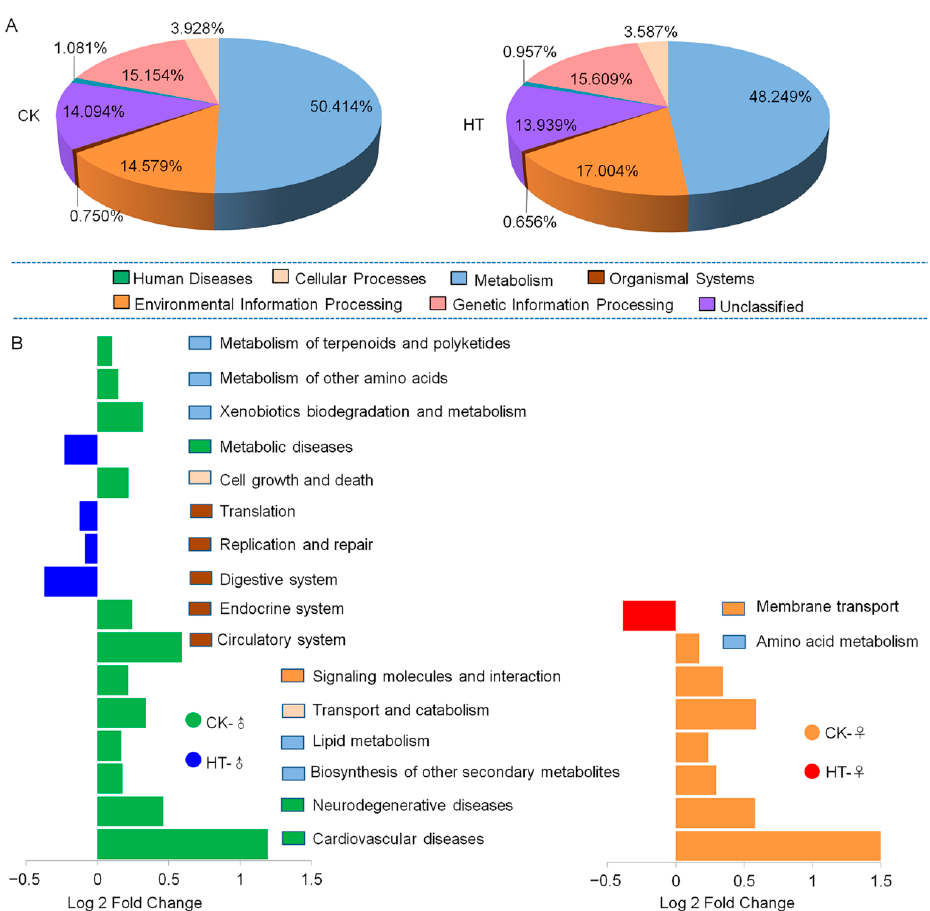
Figure 5. KEGG analysis of gut microbes of silkworm. ( A ) DistributiEW2on of primary metabolic pathways of intestinal microbes KEGG (Kyoto Encyclopedia of Genes and Genomes). ( B ) There are significant differences in the intestinal microbial KEGG secondary metabolic pathways between female and male silkworms in high-temperature environments. The bar plot shows pathways that were significantly enriched ( p < 0.05) as determined by one-way ANOVA. Fold change of the main discriminant between CK- and HT- ; fold change of the main discriminant between CK- and HT- ♀ ♀ ♂ ♂